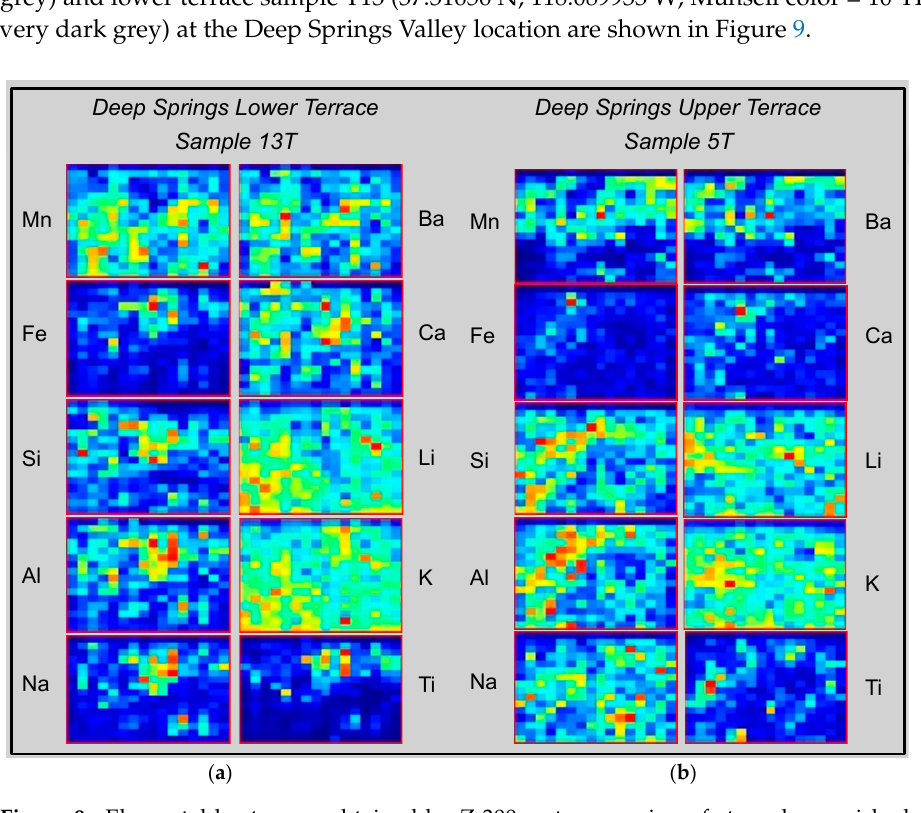
Figure 9. Elemental heat maps obtained by Z-300 raster scanning of strongly varnished desert pavement clasts on the lower ( a ) and upper ( b ) terraces in Deep Springs Valley. Elemental variations are shown in a gradient of colors that varies from red for high abundance to blue for low abundance. Note the heterogeneous distribution of elements across the 2 × 2 mm surface domain sampled, a feature that is characteristic of the ten varnished clasts analyzed on the two terraces. The panels for samples 5T and 13T in Figure 9 display the spatial distributions of elemental concentration variation across a 2 mm domain on the surface of the varnish layer for 10 elements—Mn, Fe, Si, Al, Na, Ba, Ca, Li, K and Ti. Elemental abundances display an uneven distribution across the surface of the varnish layer at the pixel scale of the heat maps. The distribution of Mn for the varnished clast on the lower terrace is fairly even, whereas it is concentrated in just half of the sampling domain for the clast on the upper terrace. The surface of the clast on the lower terrace is richer in Mn, Ba and Ca overall than that on the lower terrace, which displays comparatively elevated abundances of Si, Al and Na. The most striking feature of these maps is the complementary character of the elemental distributions; Ba and Ca distributions are spatially coherent with Mn, whereas Al and Na track Si distributions, Ti distributions track those for Fe, and Fe and Mn distributions are uncorrelated. Concentrations of Li and K are significant and fairly evenly distributed in both samples. 5.3.2. Depth Profiling Depth profiling is one of the unique capabilities of handheld LIBS. A single laser shot by LIBS provides an analysis of the sample surface, but tunneling in the sample at a single location is also possible as successive laser shots ablate the sample to progressively greater depths. As noted above, the varnished quartzite clast from Death Valley was analyzed in the laboratory prior to a depth profiling study prior to our use of another analyzer in the field. Previous profiling studies undertaken initially using electron microprobe analysis and, more recently, energy dispersive X-ray analysis, provided important insights into the